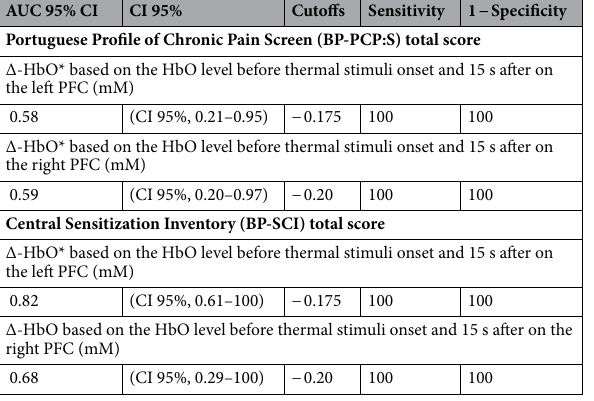
Table 6. ROC analysis to screening the severity of fibromyalgia symptoms according to the right and left PFC activation based on Δ-HbO* (n = 22). AUC area under the curve, CI confidence interval, ROC receiver operator characteristics, mM